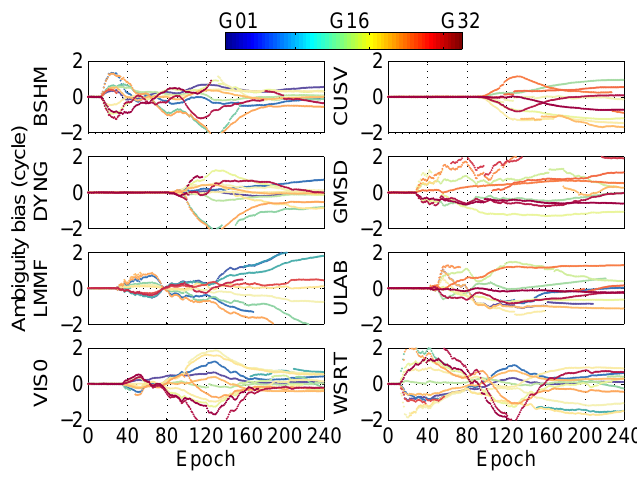
Figure 18. Ambiguity bias at different stations in the real-time PPP.